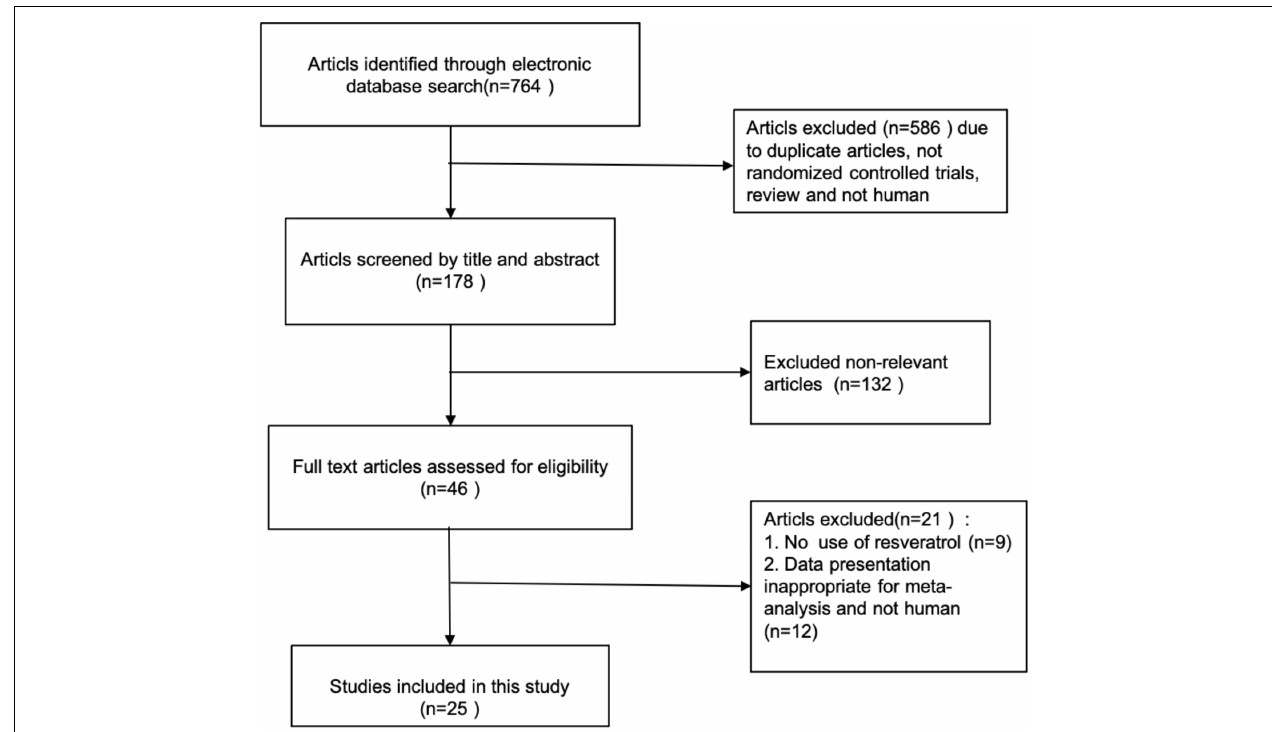
FIGURE 1 | Literature search and review flowchart for selection of studies.